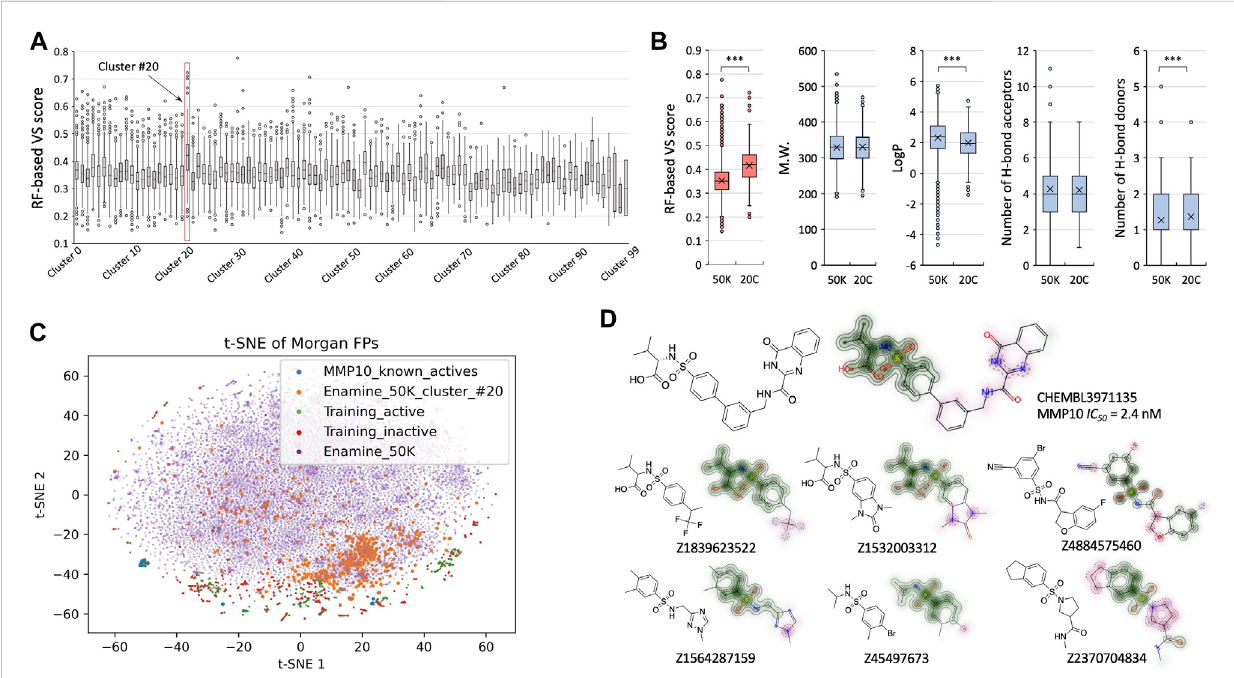
FIGURE 4 Structural insights revealed from the screening. (A) . Box and Whisker plots for RF-based VS scores across structurally clustered groups of Enamine 50K library. (B) . Comparison of VS scores and properties between cluster #20 and the remaining part of the Enamine 50K library. (C) . t-SNE analysis to visualizecoveredchemicalspacesbyknownMMP10actives(blue),cluster#20(orange),activemoleculesinthetrainingset(green),inactivemoleculesin the training set (red), and full Enamine 50K compounds (purple). (D) . One known MMP10 inhibitor and exempli fi ed compounds in cluster #20. The overlapping benzenesulfonamide group is highlighted in green. Dissimilar moieties are colored